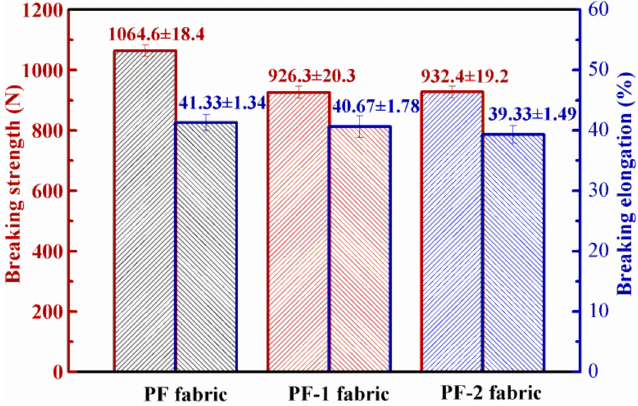
Figure 10. Tensile properties of PET fabrics.